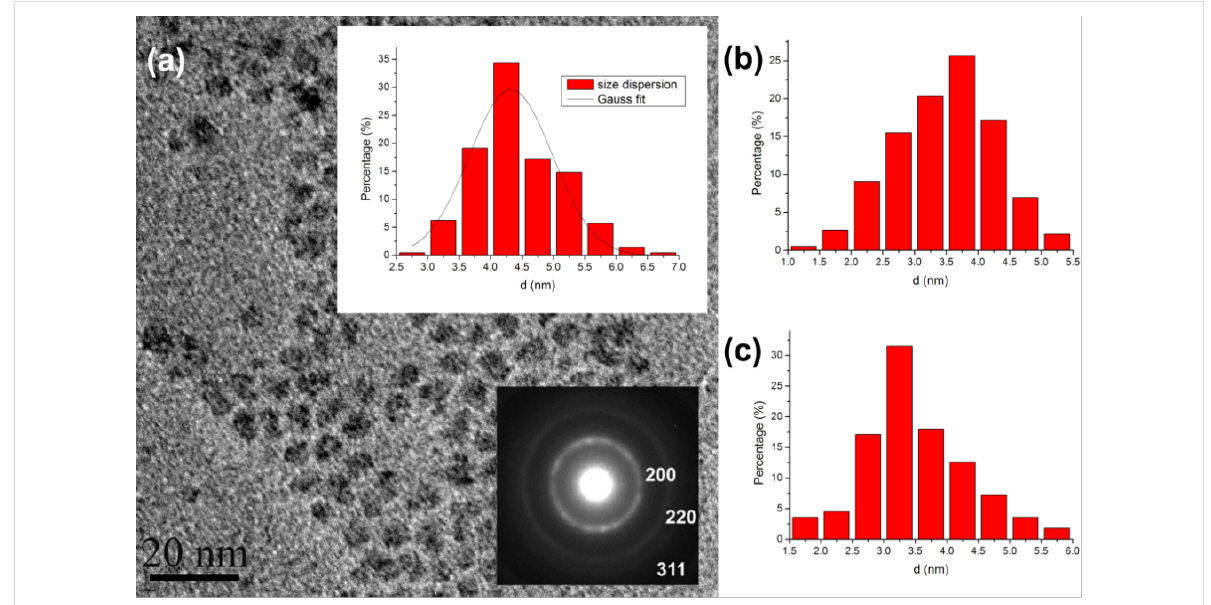
space group No. 216, a = 5.868 Å). The reflections were indexed as (111), (220) and (311) planes. Increasing the Zn amount leads to broader peak shapes, which suggests a